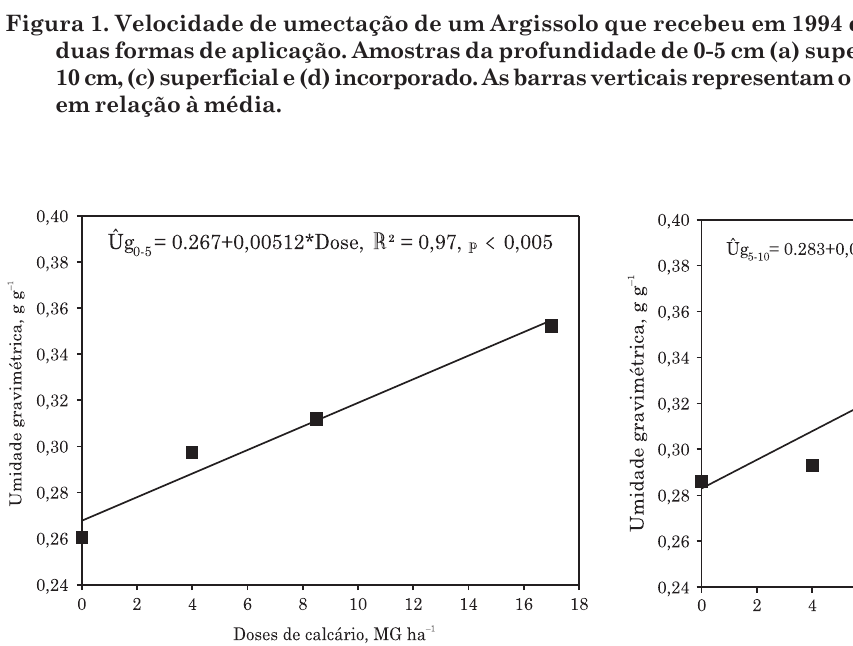
Figura 3. Relação entre a umidade gravimétrica na máxima retenção de água no ensaio de ascensão capilar de acordo com as doses de calcário aplicadas em um Argissolo, camada de 5-10